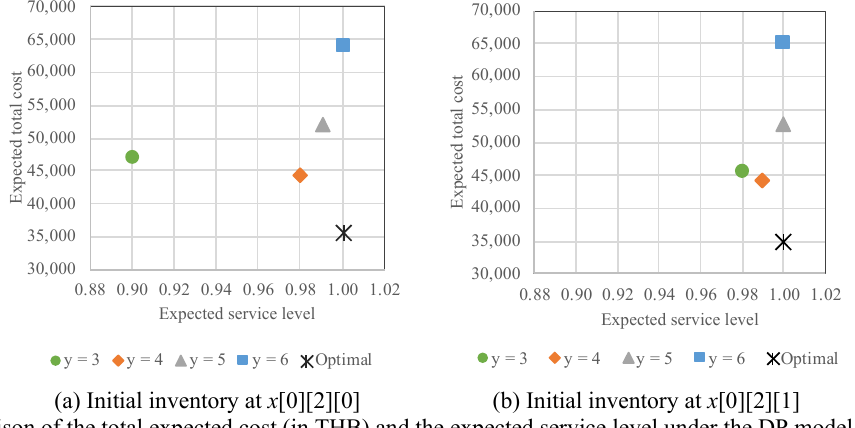
(a) Initial inventory at x [0][2][0] (b) Initial inventory at x [0][2][1] Fig. 9. Comparison of the total expected cost (in THB) and the expected service level under the DP model and the optimal fixed replenishing order quantity Optimal policy (in THB) given the number of initial inventories with and without shortage allowance Initial inventory on